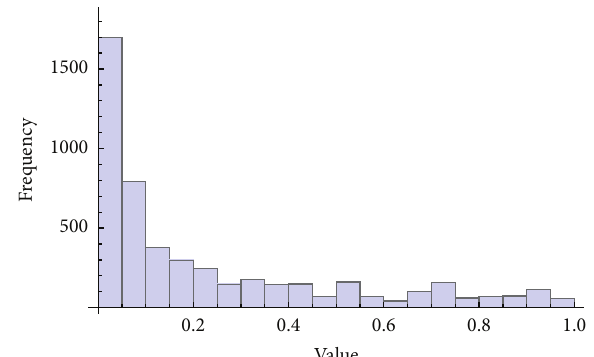
Figure 3: Histogram of the distribution of real numbers transferred into the range ⟨0 - 1⟩ generated by means of the chaotic Burgers map, 5000 samples.